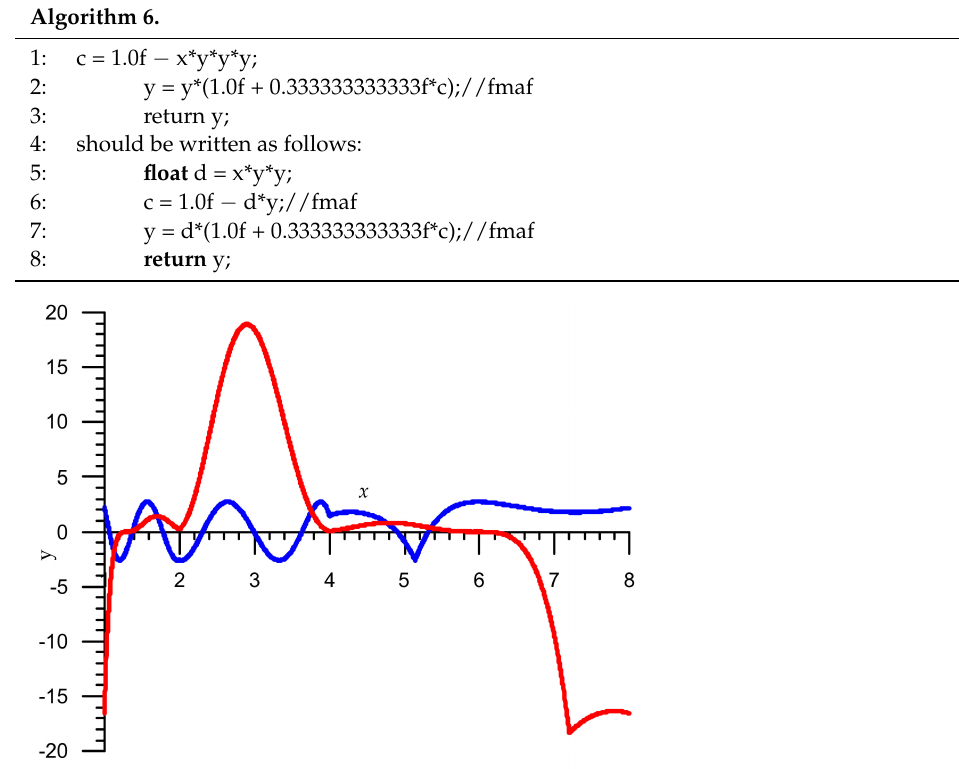
Figure 5. The first iteration relative error graphs for the interval x ∈ [1,8) (red colour: Algorithm 4, blue colour: Algorithm